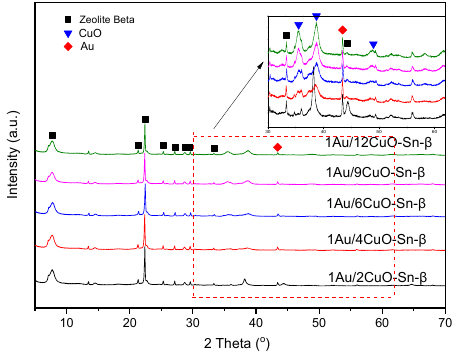
Figure 2. The XRD patterns of Au/CuO-Sn- β with different Au contents.